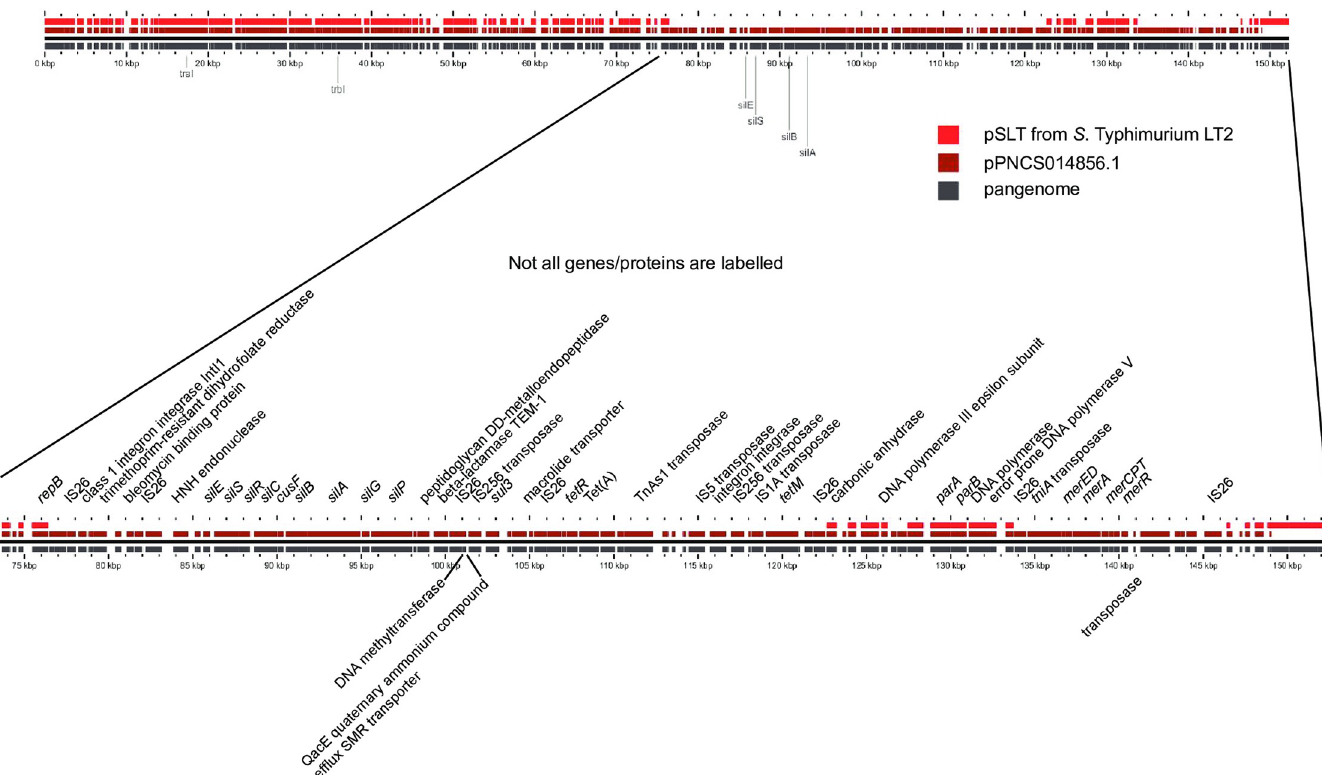
Fig 8. GView pangenome comparison of the genomes of plasmid pSLT and pPNCS014856.1. Almost all genes of pSLT are contained within pPNCS014856.1, which has indels associated with genes from SGI-4 and the MREL, as well as genes from other sources. pPNCS014856.1 was used as the reference to show that the mercury resistance genes from the MREL are inserted at a different location within pSLT than genes conferring antibiotic resistance from the MREL and silver resistance from SGI-4.